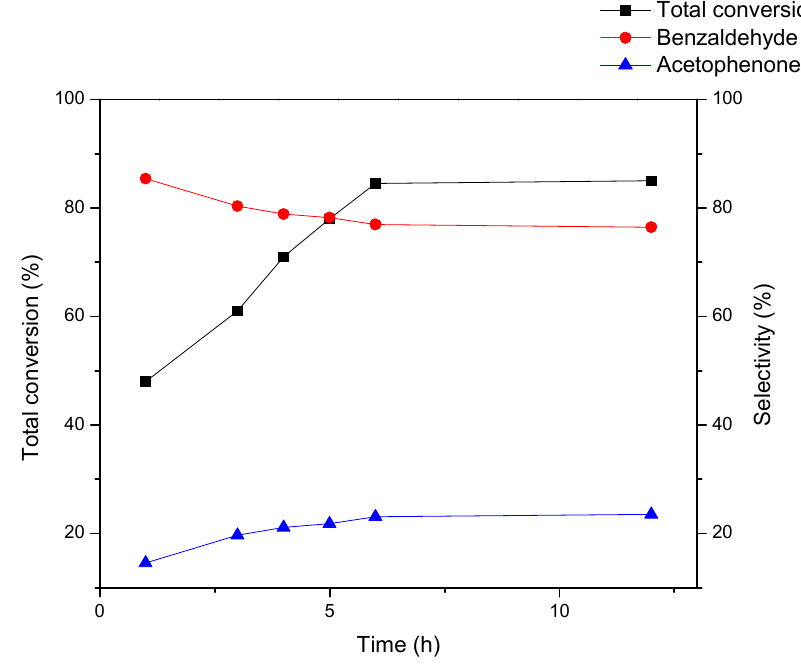
Figure 5. Time dependence profile and selectivity for the oxidation of styrene catalyzed by 3 .